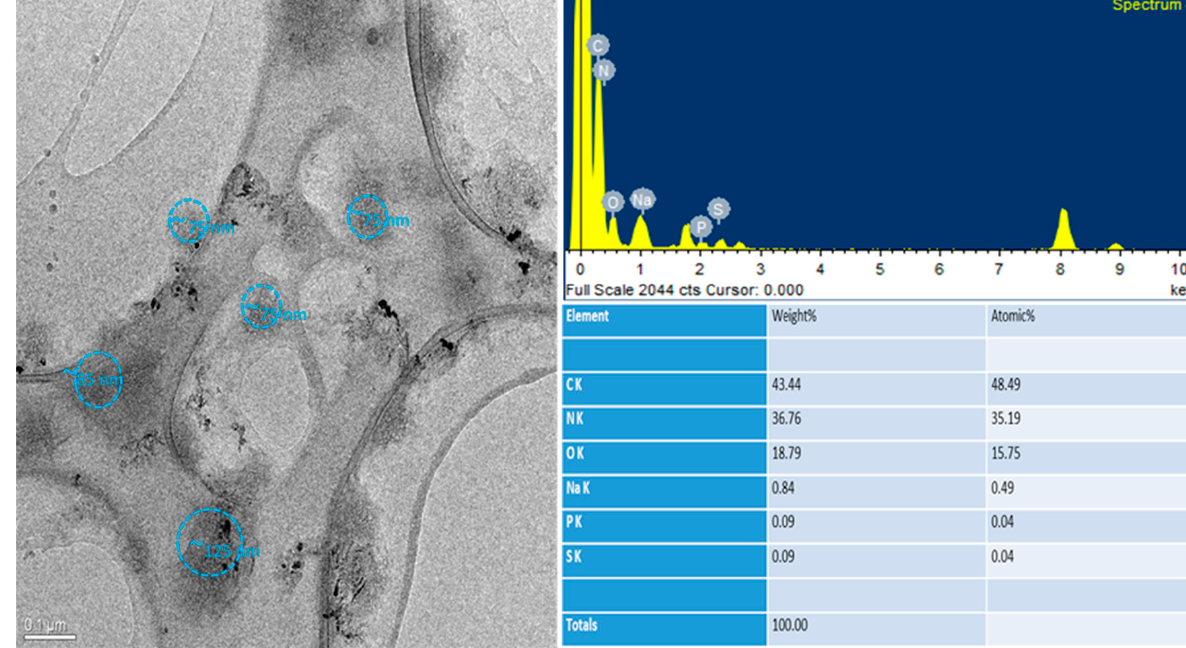
Figure 7. Morphological and elemental analysis of HA-NP-CTAB by TEM.